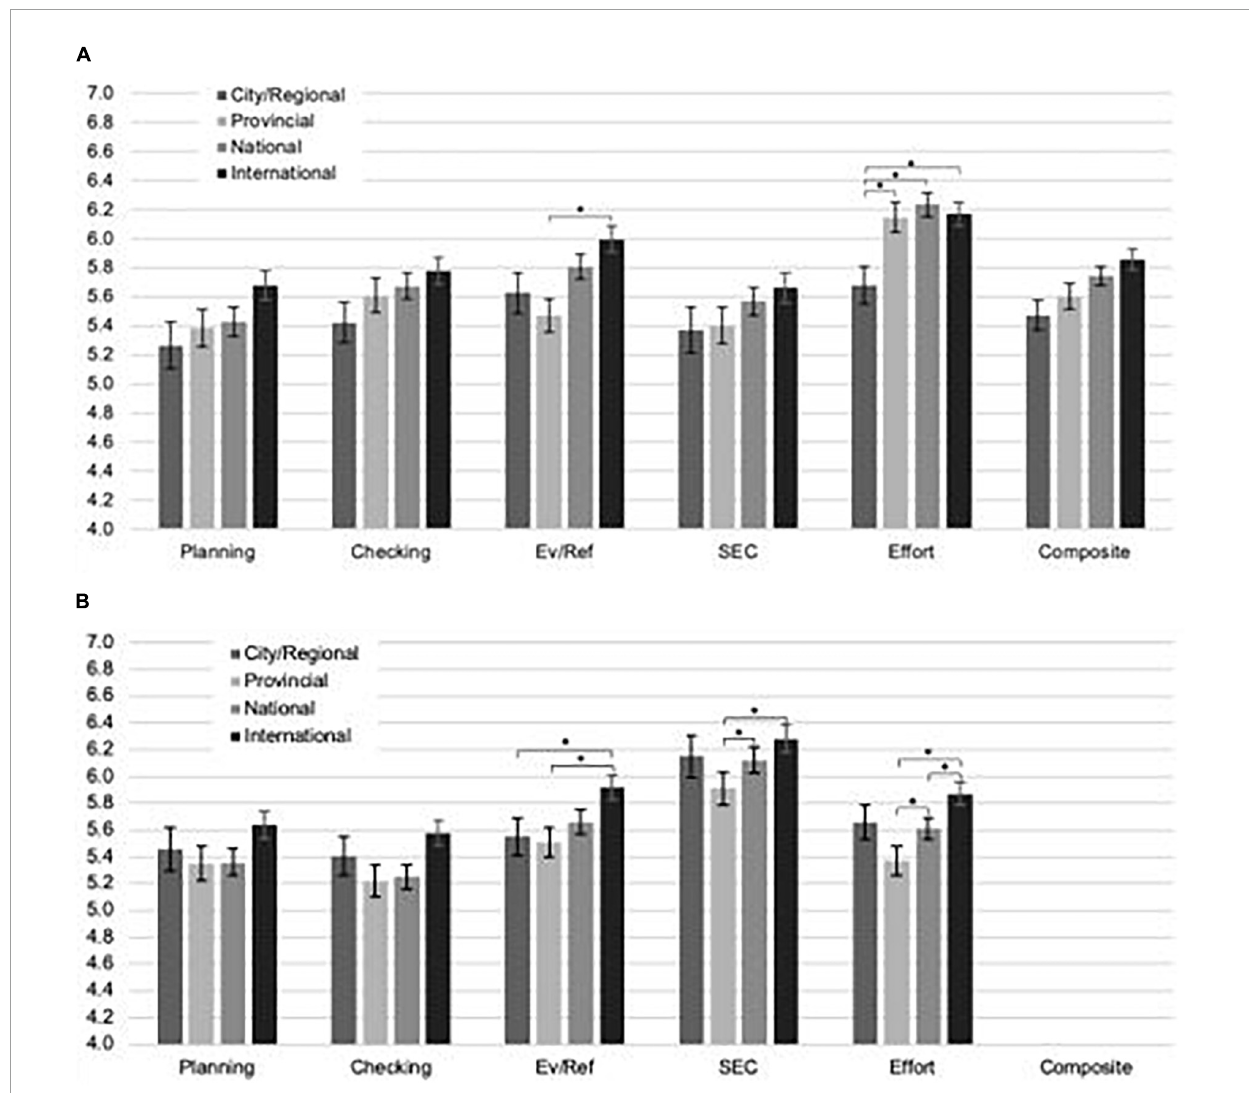
FIGURE1 (A) Subscale and composite scores on the SRSP reported in Wilson et al. (2021b), presented by skill level group. (B) Subscale and composite scores on the SRL-SP reported by McCardle et al. (2018), presented by skill level group. * p < 0.05; Error bars represent standard error of the mean.